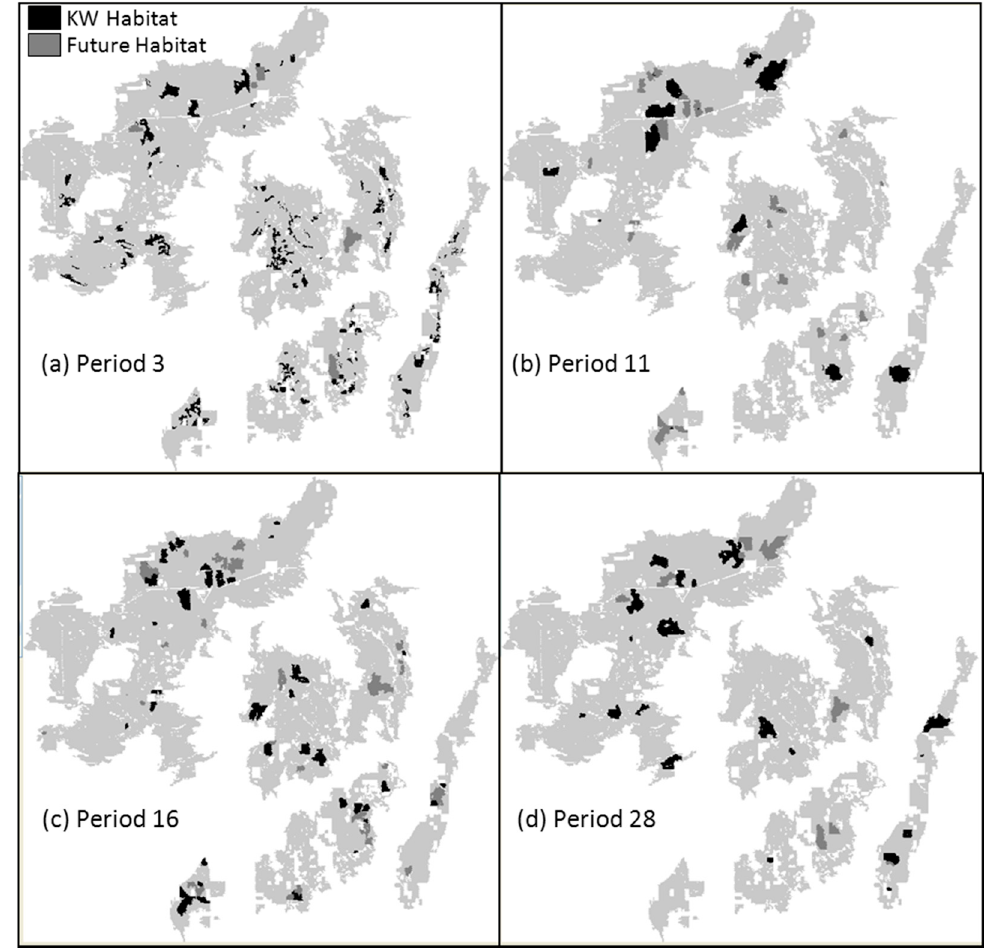
Figure 7. Results from S3 2226 scenario (2226 ha core area constraint) for select time periods. KW Habitat is currently at appropriate stocking levels between the ages of 6 and 16, and Future Habitat is currently between ages 0 and 6.